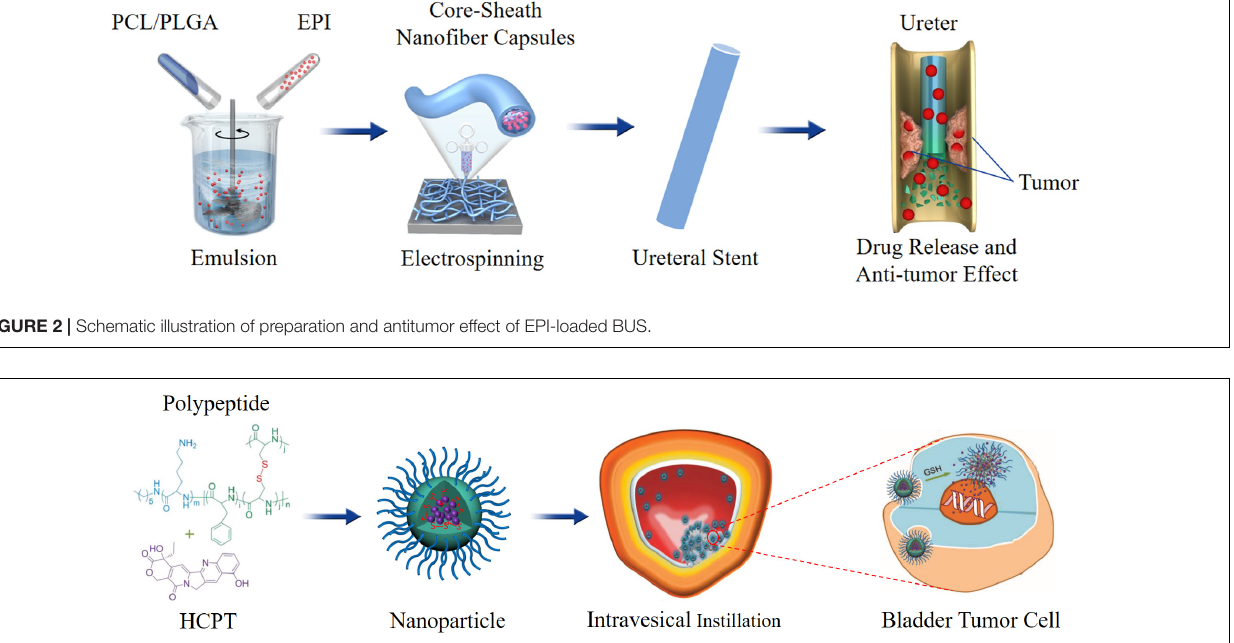
FIGURE 3 | Schematic illustration of chemical structure of polypeptide/HCPT nanoparticles and its metabolic process. Reproduced from Guo et al. (2018) under open access license.